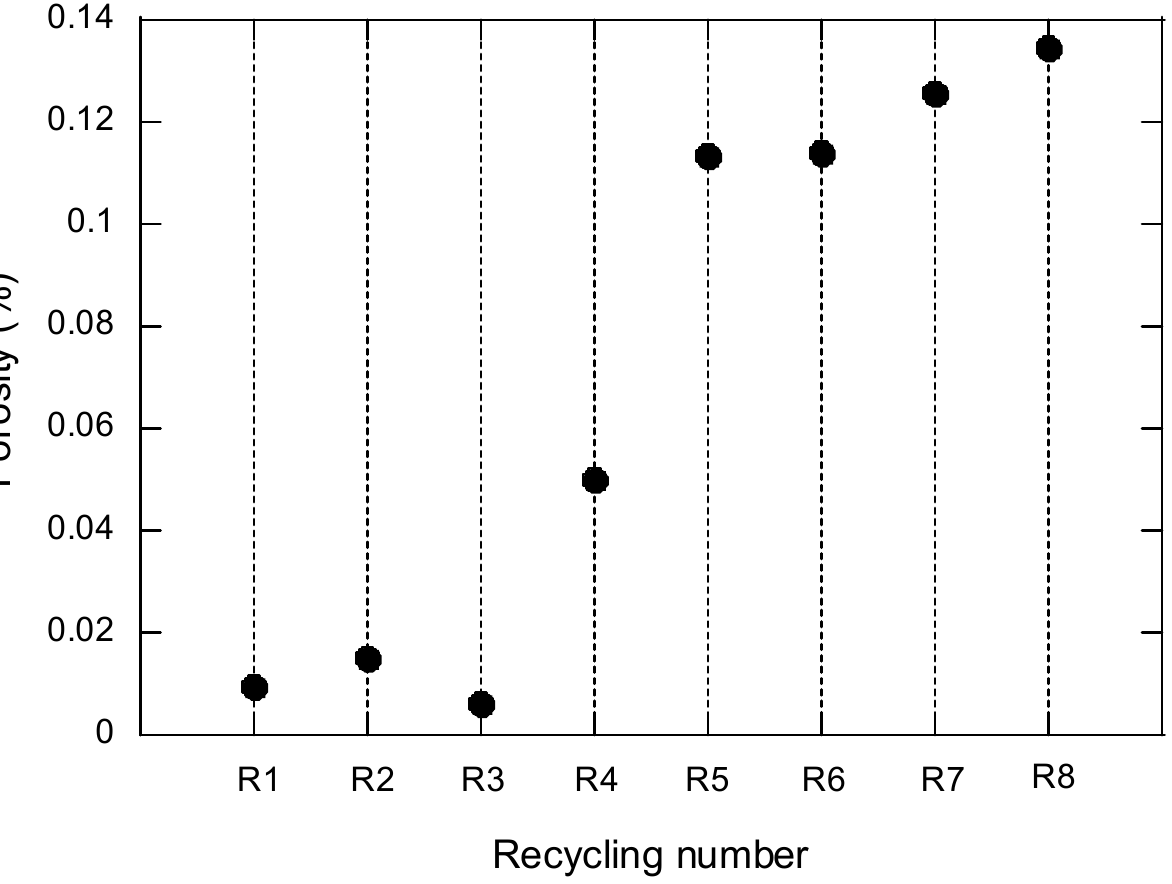
Figure 13. Porosity measured by means of µCT.